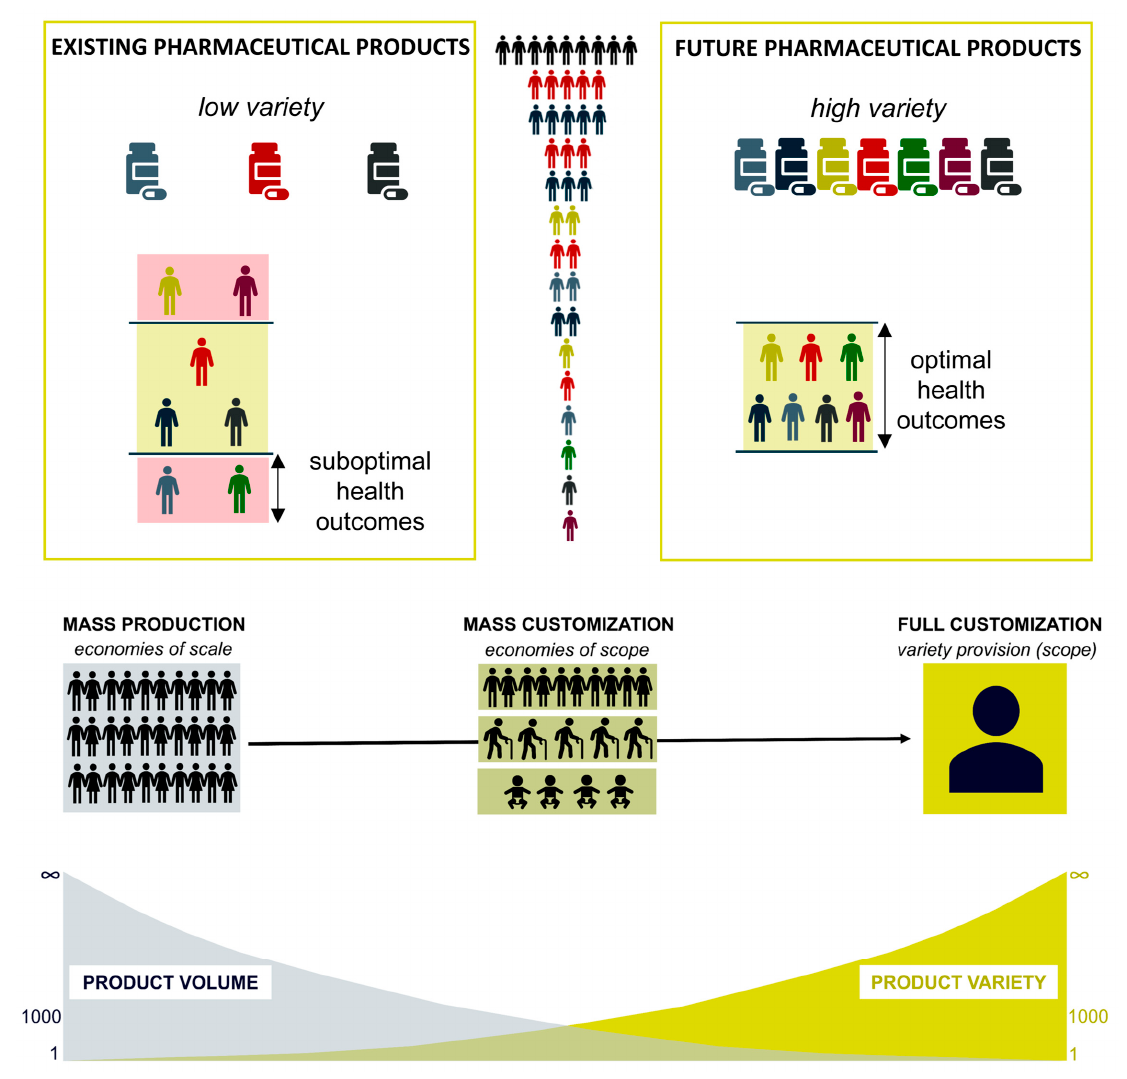
Figure 1. The need for personalization of pharmaceutical products and changes in product volume and variety due to product customization according to the needs of individual patients. This figure has been reproduced with permission from © 2021 Rydvikha Govender